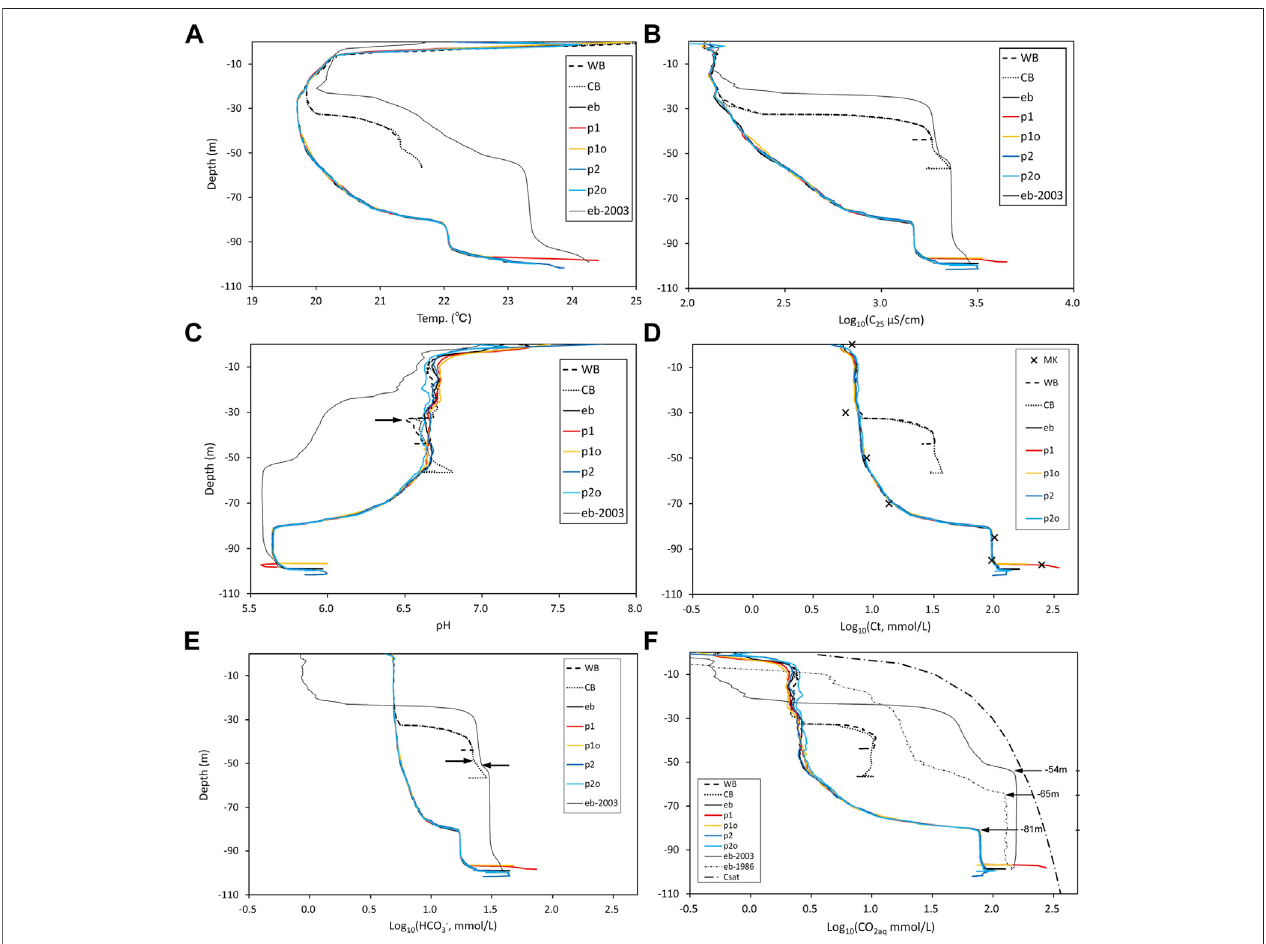
FIGURE 5 | Vertical pro fi les in Lake Monoun. (A) Temperature pro fi les measured in 2015 at point eb in Figure 4 along with the pro fi le in 2003 (Kusakabe et al., 2008). (B) C 25 pro fi lesin2015atpointebin Figure4 alongwiththe2003pro fi le(Kusakabeetal.,2008).The x -axisisthelogarithmofC 25 (µS/cm). (C) pHpro fi lesin2015 at point eb in Figure 4 along with the 2003 pro fi le (Kusakabe et al., 2008). (D) Estimated Ct pro fi les in 2015 along with the Ct ( “ x ” ) measured using the MK method. The x -axis is the logarithm of Ct (mmol/L). (E) Estimated [HCO 3 ‾ ] pro fi les along with the 2003 pro fi le measured at point eb in Figure 4 . The x -axis is the logarithm of [HCO 3 ‾ ] (mmol/L). (F) Estimated [CO 2aq ] pro fi les at point eb in Figure 4 along with the 1986 and 2003 pro fi les (Kusakabe et al., 2008). The bold dashed and dotted line indicates the saturated